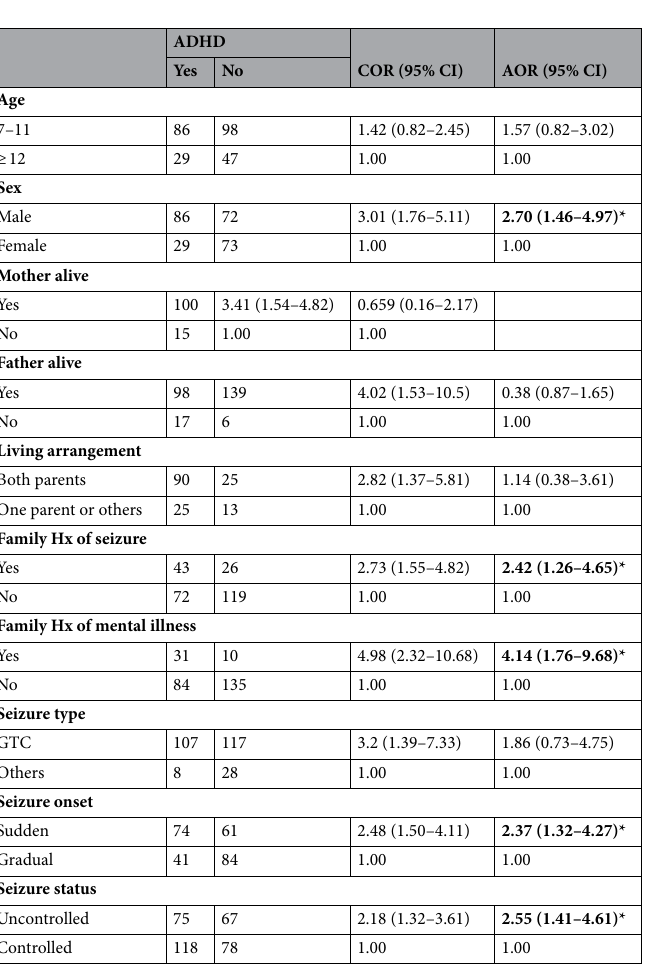
Table 4. Factors associated with ADHD among children with seizure disorders at University of Gondar referral hospital. *means P-value <